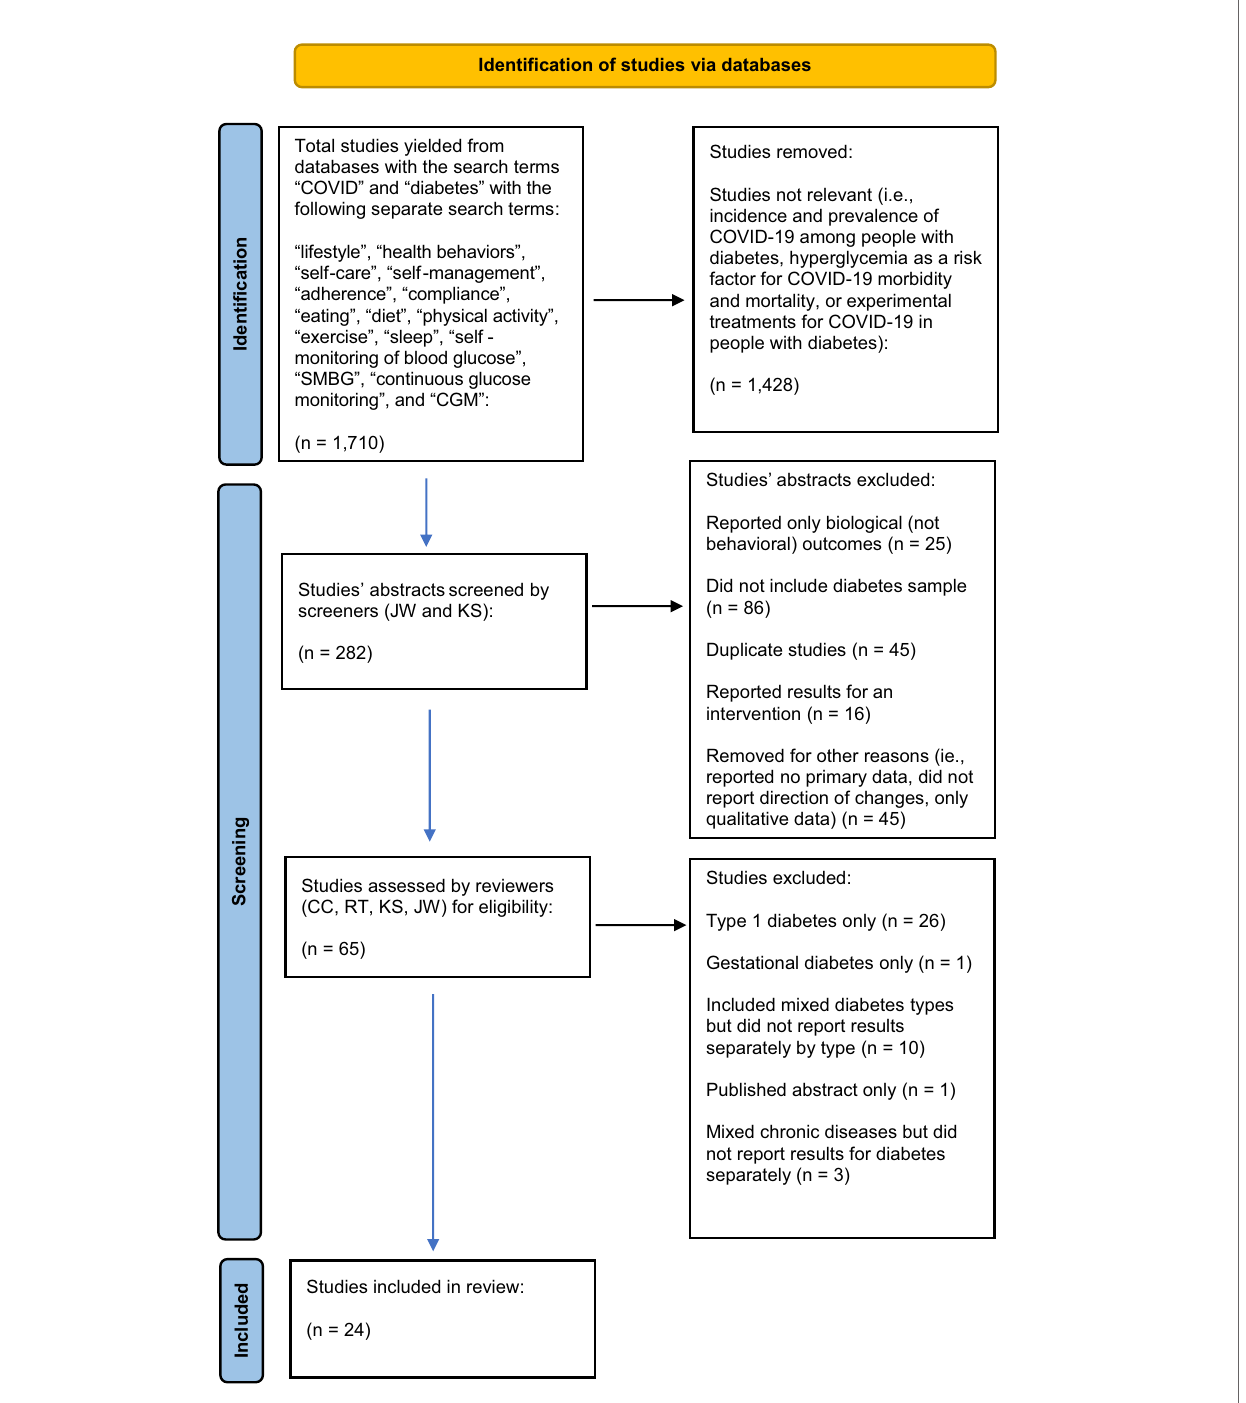
FIGURE 1 | PubMed, PsychInfo, and Google Scholar databases from December 2019 through August 2021.Page MJ, McKenzie JE, Bossuyt PM, Boutron I, Hoffmann TC, Mulrow CD, et al. The PRISMA 2020 statement: an updated guideline for reporting systematic reviews. BMJ 2021;372:n71. doi: